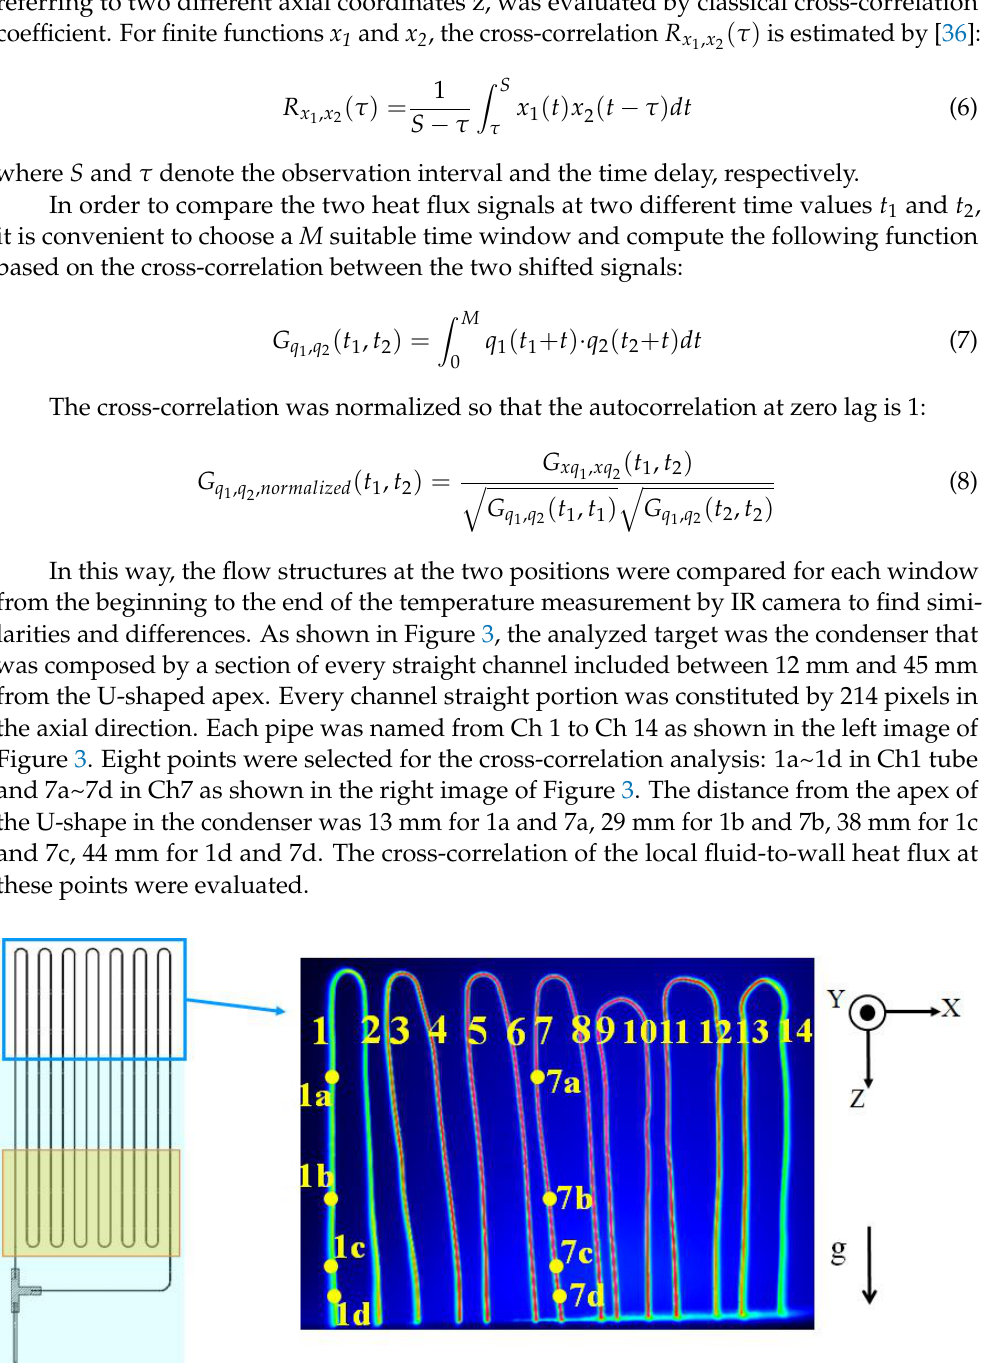
Figure 3. Channel numeration.